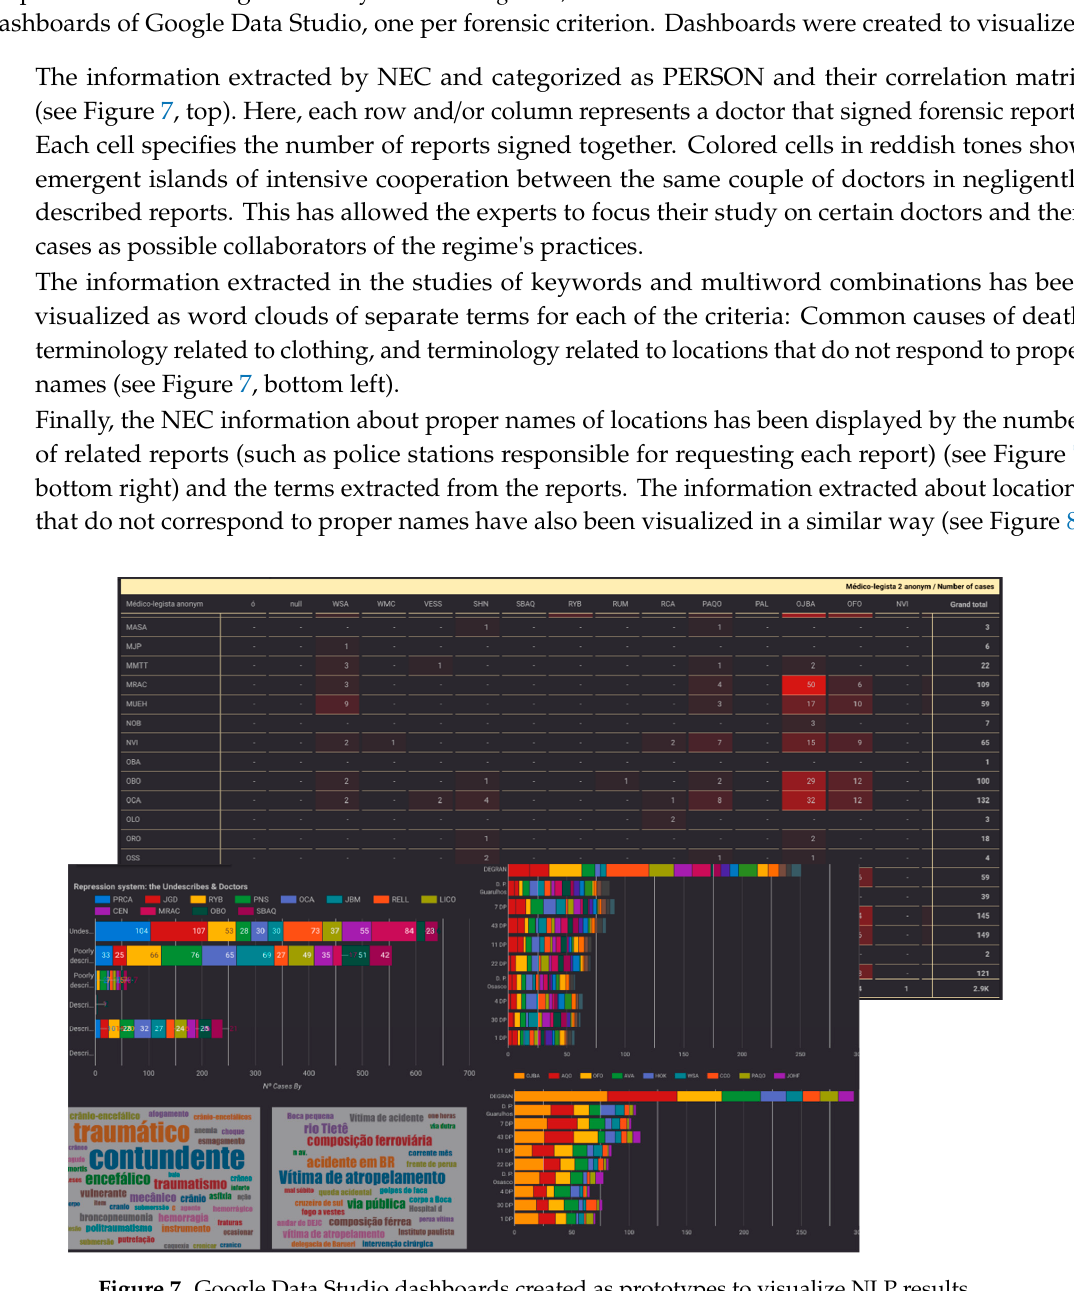
Figure 7. Google Data Studio dashboards created as prototypes to visualize NLP results.